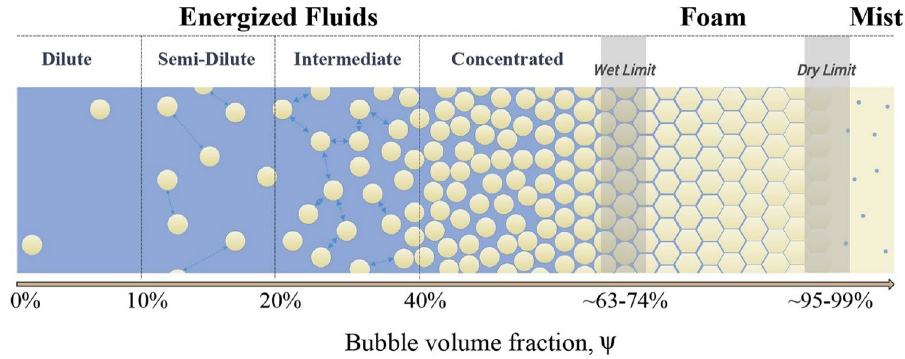
Fig. 4 General structure of the liquid foam. (Faroughi et al.